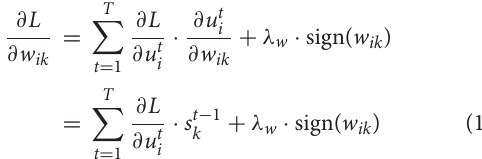
FIGURE 3 | Iterative calculation with linear algorithm complexity. At time T , the potential error comes from the direct error ε T . At time T the direct error ε T − 1 and the backpropagation of ε T . At time T requires one addition and